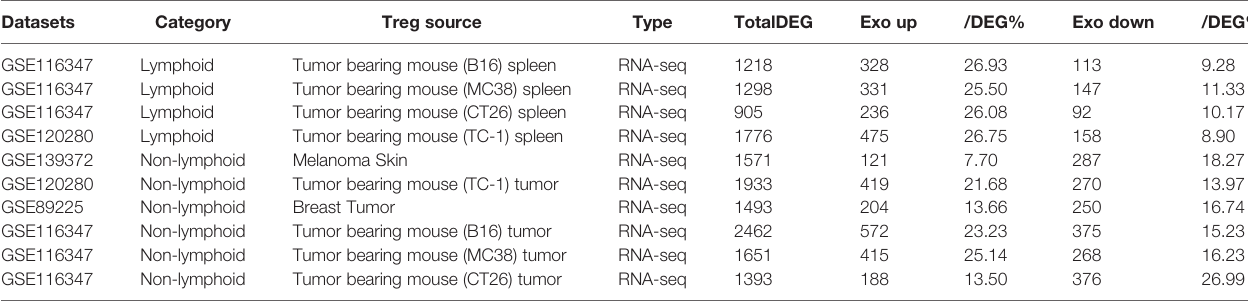
TABLE 3C | Lymphoid tissue Treg enriched more exosome pathways than non-lymphoid tissue Treg. A. Exosome gene numbers in benign disease Treg groups.